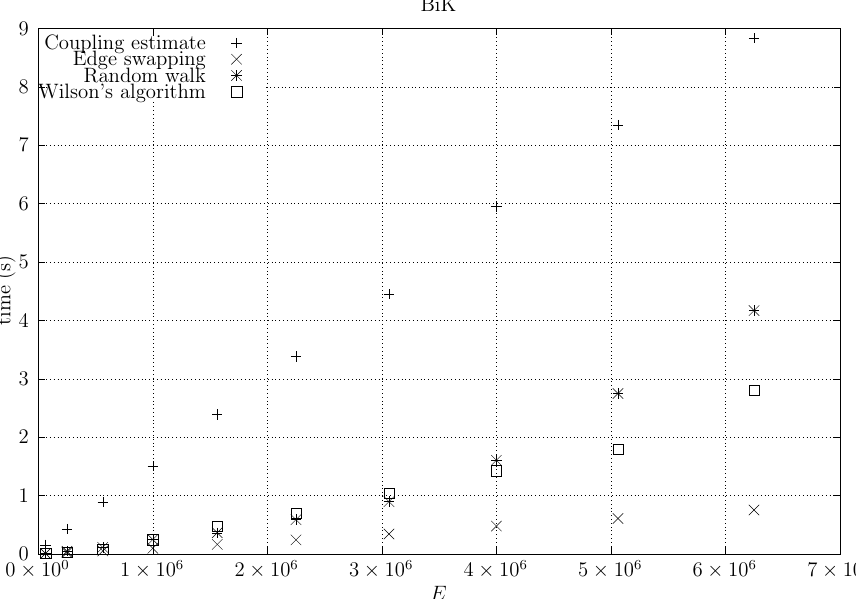
Figure 27: Running times for biK graphs averaged over five runs, including the running time for computing the optimistic coupling estimate, the running time for generating a spanning tree based on that estimate and on the edge swapping algorithm, the running time for generating a spanning tree through a random walk, and also the running time for Wilson’s algorithm.